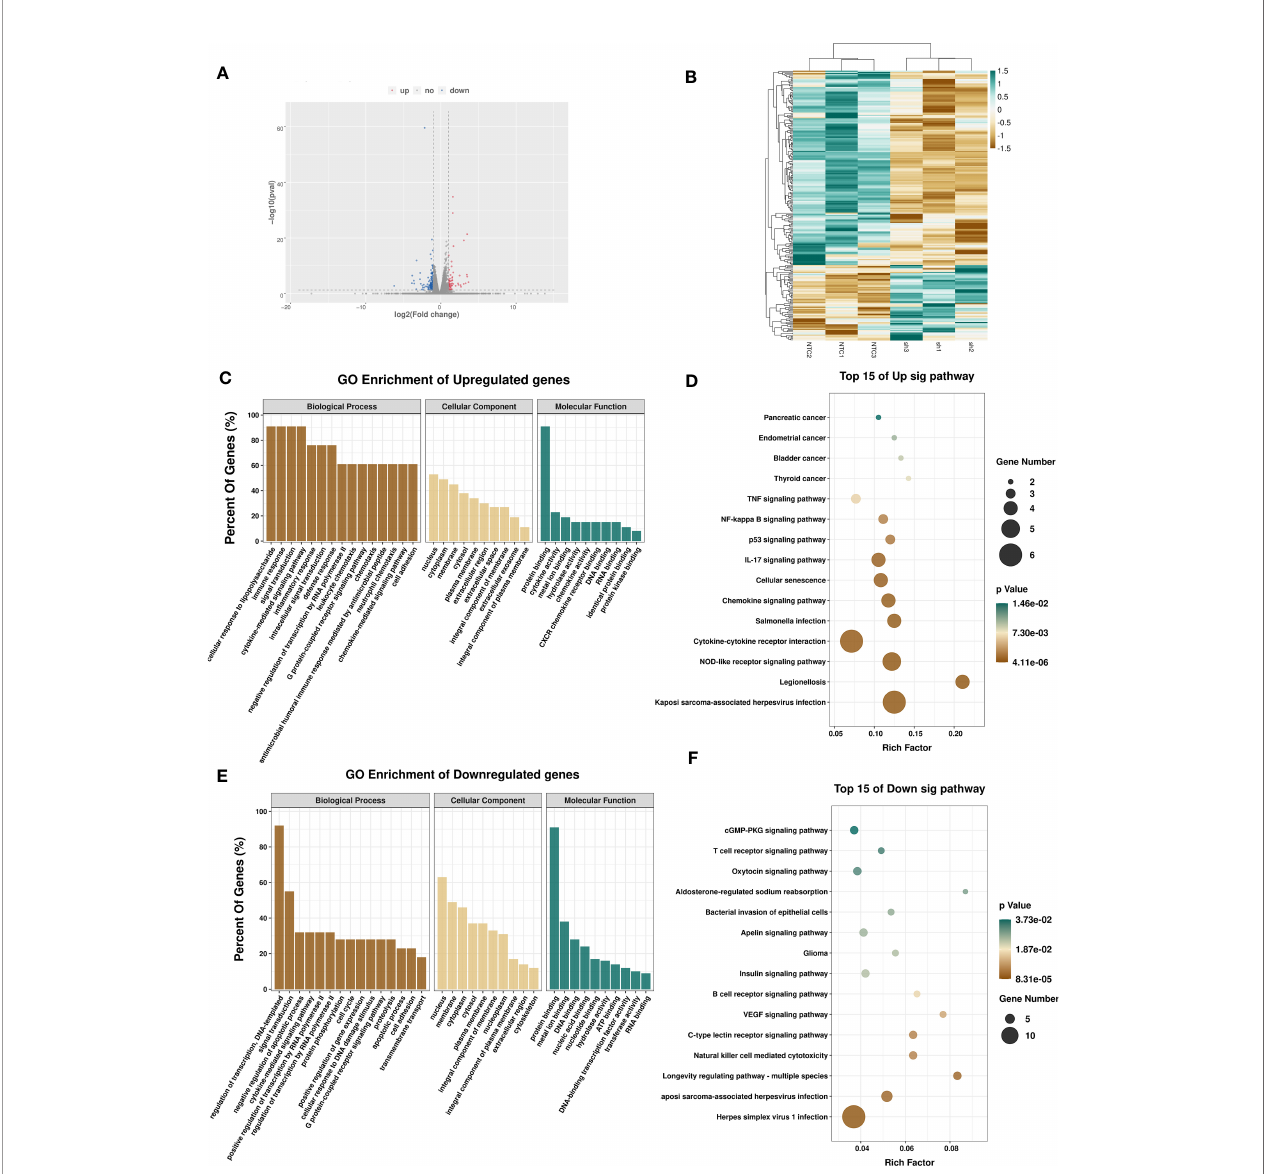
FIGURE 5 | Effects of METTL3 on transcription pro fi le of melanoma cells. (A) Volcano plot showing signi fi cantly upregulated (red) and downregulated (blue) genes between A375-NTC (NTC) and A375-shMETTL3(sh) groups. (B) Heatmap showing differentially expressed transcripts between NTC and sh groups. GO and KEGG analyses of signi fi cantly upregulated (C, D) and downregulated (E, F) genes identi fi ed via RNA-seq suggesting the involvement of DEGs in signal